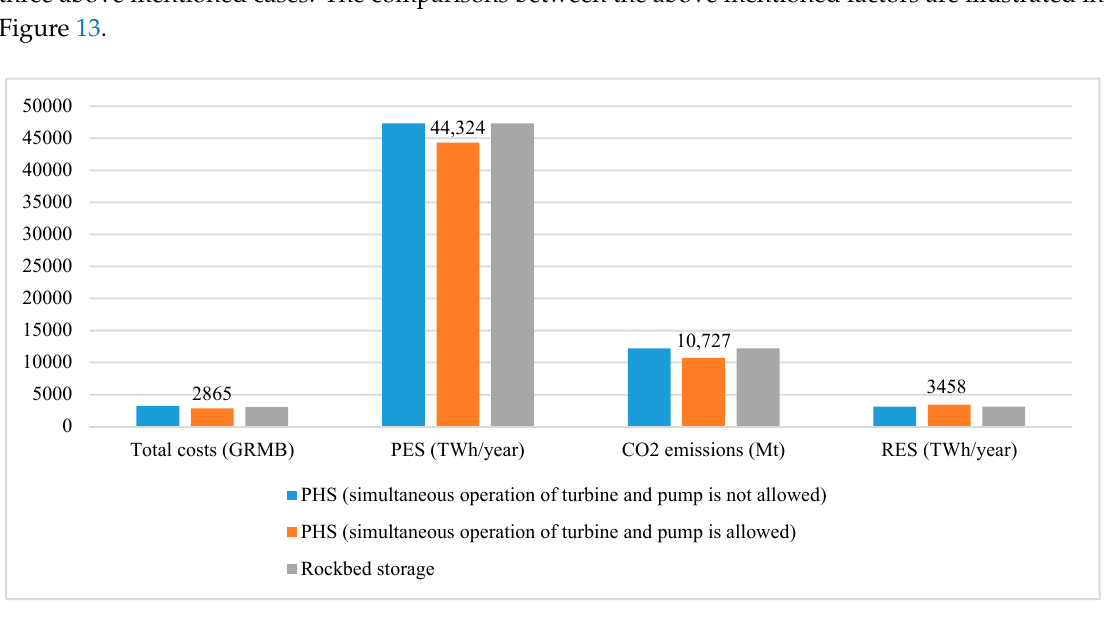
Figure 13. Comparisons of summary performance of single penstock PHS, double penstock PHS and rockbed storage.